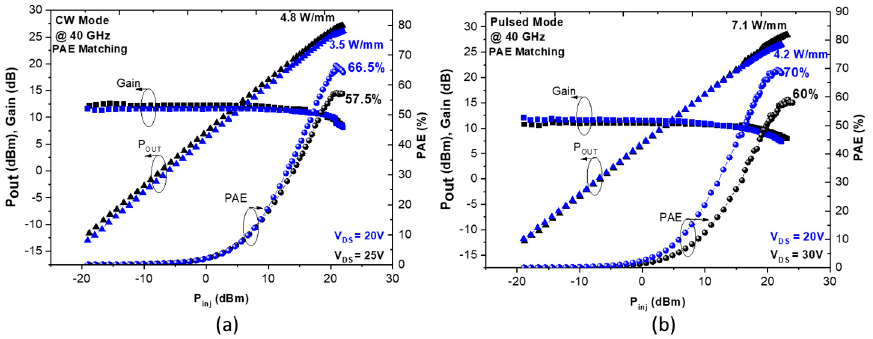
Figure 5. Typical large signal performances at 40 GHz for a 2 × 50 µm AlN/GaN HEMT (Al-25%) with L G = 100 nm and L GD = 0.5 µm in CW mode up to 25 V ( a ) and pulsed mode up to 30 V ( b ).